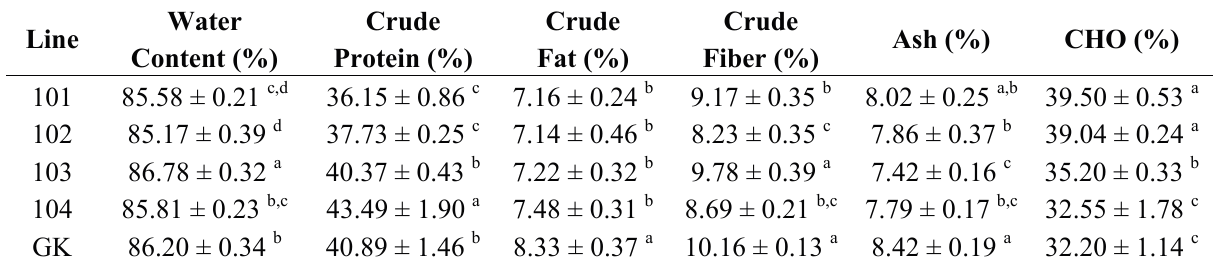
Table 1. Proximate analysis of broccoli